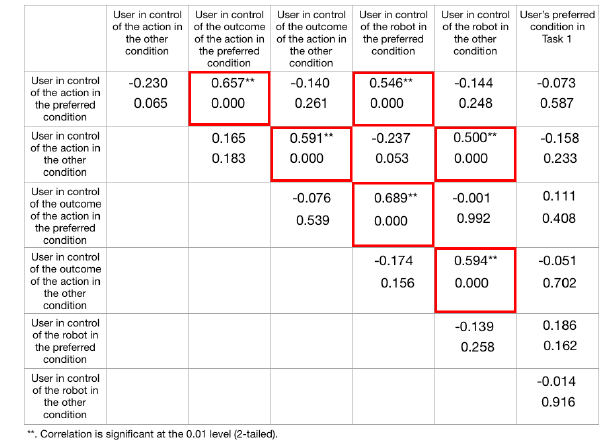
Figure 11: Correlation table for Task 1 "Lego" between the partici- pant’s preferred condition and the participant’s perception of con- trol for their preferred condition and their non-preferred condition.